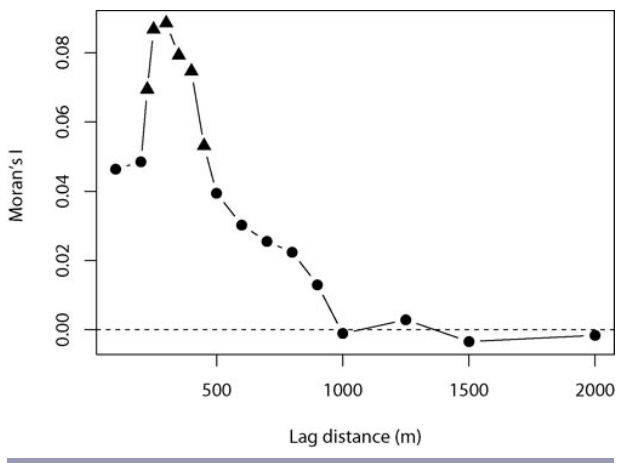
Fig. 3 . Spatial autocorrelation of deviance residuals from a generalized mixed model of Wilson’s Warbler ( Cardellina pusilla ) occurrence at Forêt Montmorency, Québec. Warbler detection was treated as a binomial response, with habitat type and area within 400 m as fixed effects, and site and year as random effects. Triangles denote Moran’s I values significantly greater than